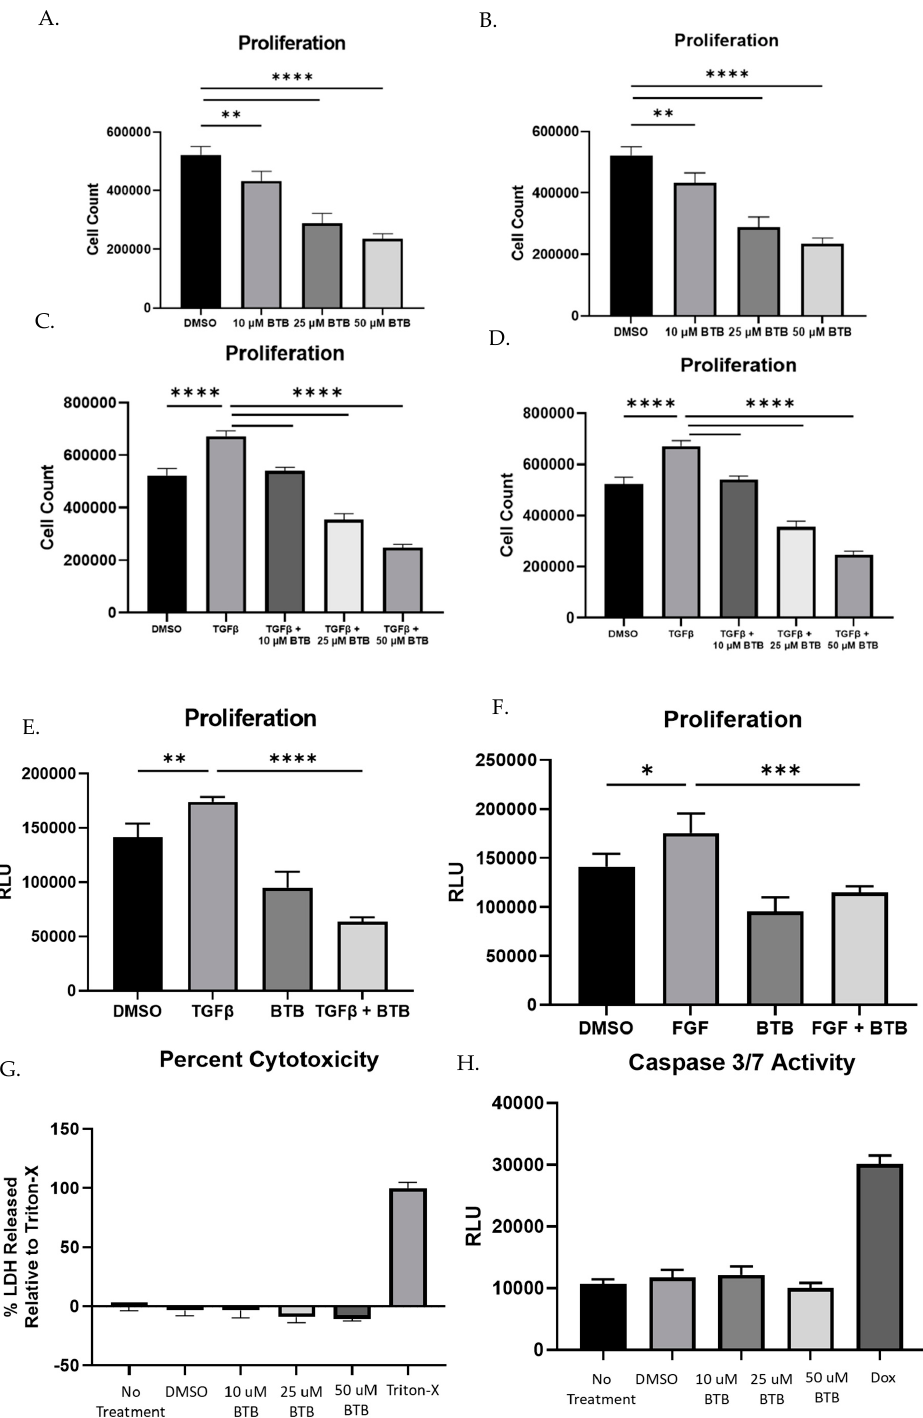
Figure 5. BTB inhibits proliferation without inducing cell death. Fibroblasts were grown in 24 well plates for 72 h with the indicated dose of BTB (50 µM where not indicated), 1 ng/mL TGF or 5 ng/mL FGF. In panels A–D, cell counts were obtained by trypan blue staining and automated cell counting. Cell counts were performed on non-fibrotic and IPF derived fibroblasts at the baseline ( A , B ) and in response to TGF β ( C , D ). ATP production was used as an indirect measure of proliferation in non- fibrotic fibroblasts ( E , F ). Cytotoxicity was assessed by LDH release ( G ), and a caspase 3/7 activity assay was performed (H). Data were analyzed by ANOVA. n = 4–6 technical replicates/group. * p < 0.05, ** p < 0.01, *** p < 0.001, **** p < 0.0001.